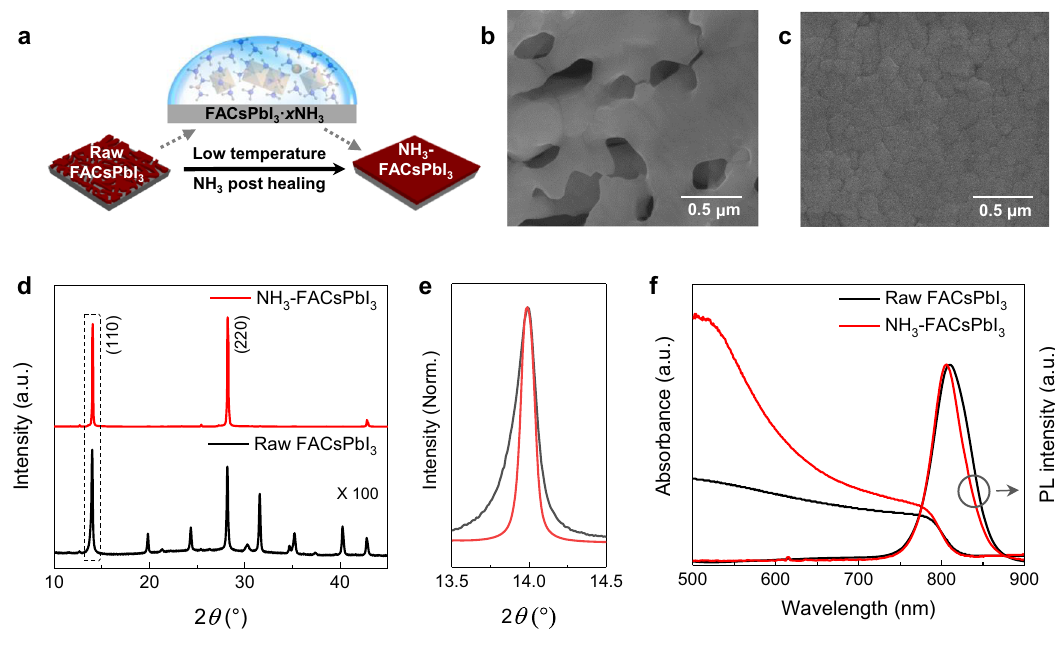
Fig. 3 | Properties of perovskite Films. a Schematic illustration of NH 3 post- healing FACsPbI 3 perovskite thin fi lm. b , c Scanning electron microscope (SEM) images of (b) raw FACsPbI 3 and (c)NH 3 -FACsPbI 3 perovskite fi lms. d , e X-ray